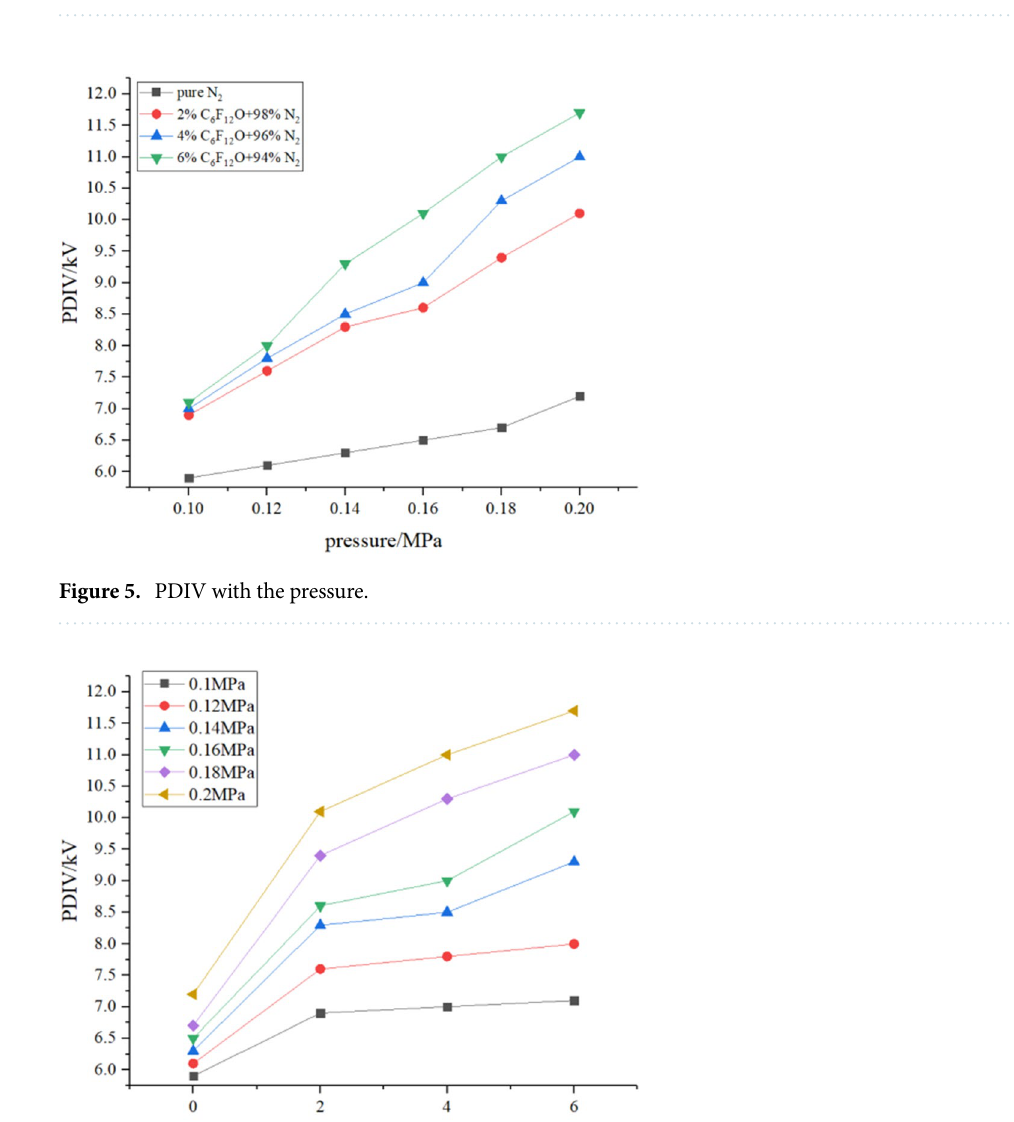
Figure 4. Typical partial discharge waveform.